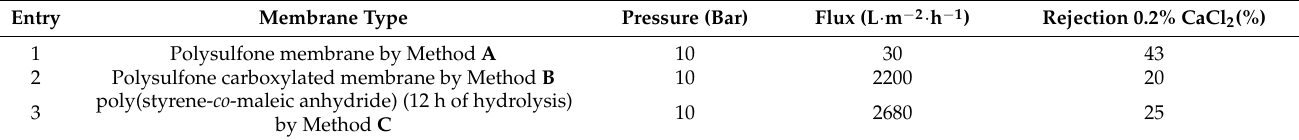
Table 2. Comparison in the performance of the membranes obtained by the three disclosed methods.